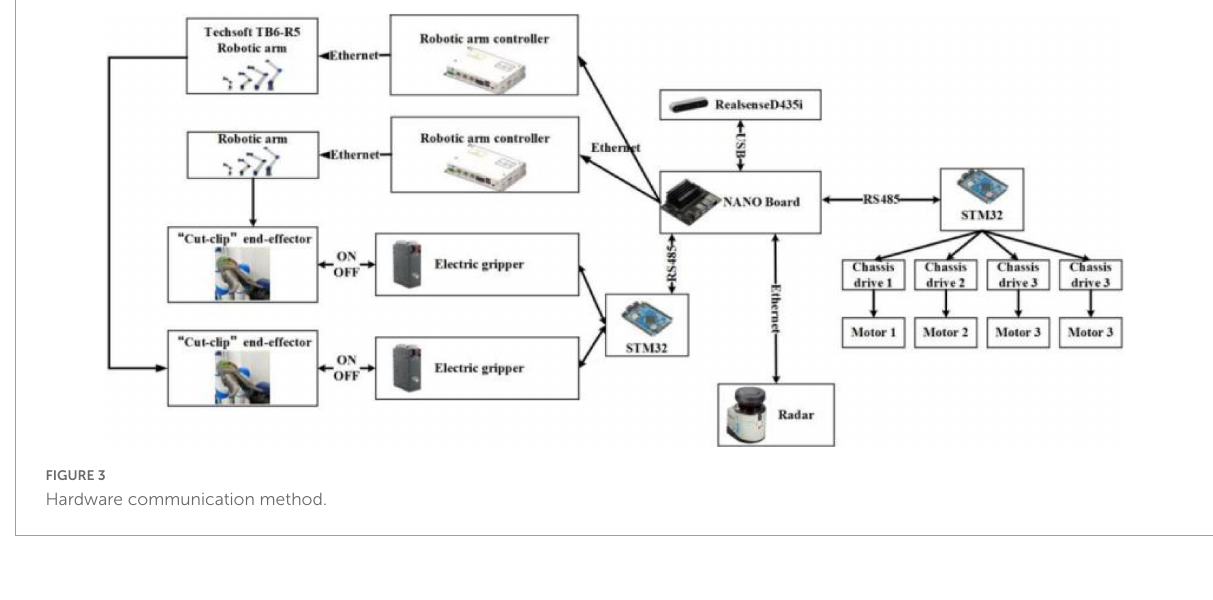
FIGURE3 Hardware communication method.